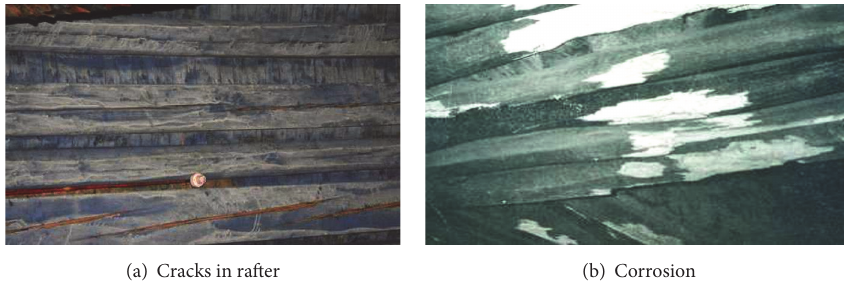
Figure 19: Damage of